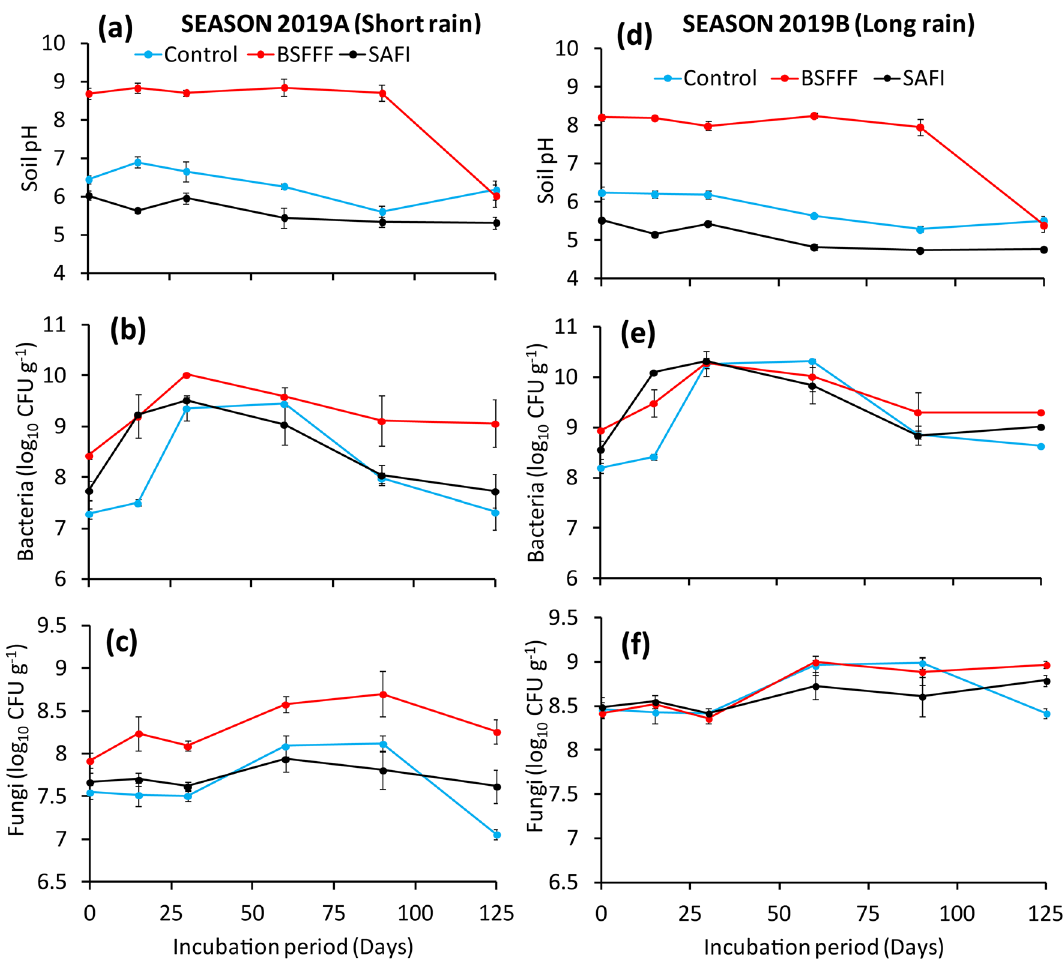
Figure 1. Changes in pH ( a , d ), and populations of bacteria ( b , e ) and fungi ( c , f ) of soil treated with different fertilizers during the short ( a – c ) and long rainy ( d – f ) seasons incubation